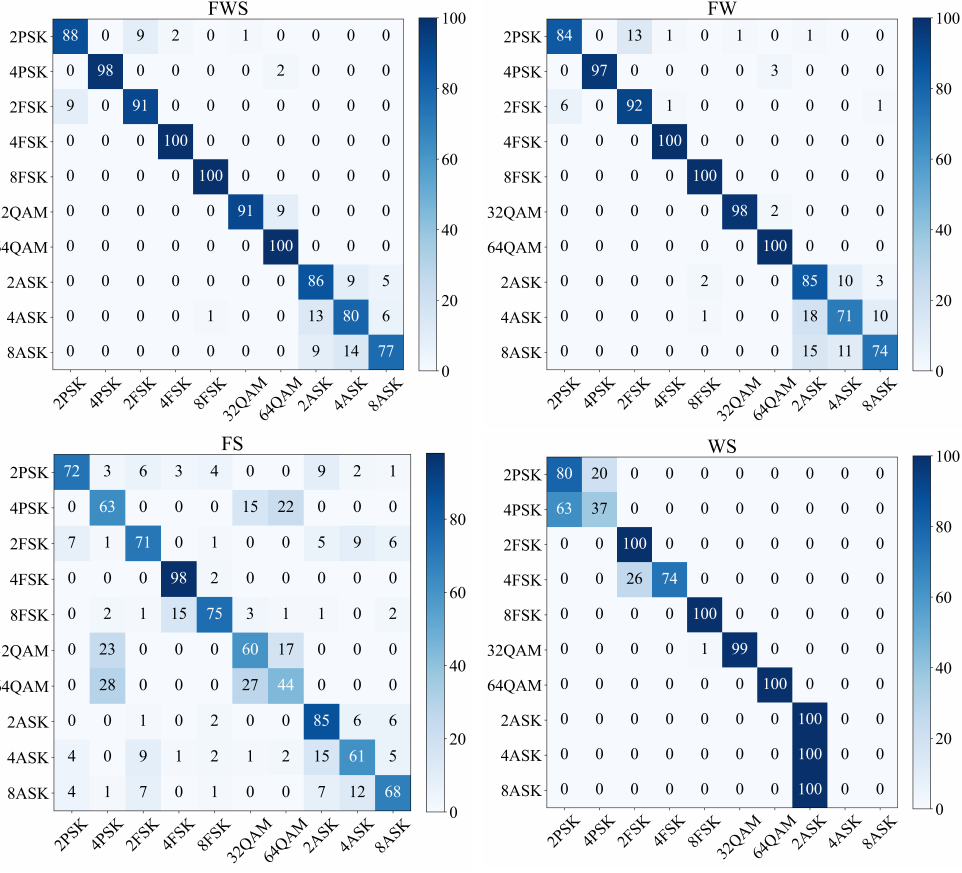
Figure 7. Confusion matrix of different methods when SNR = − 6